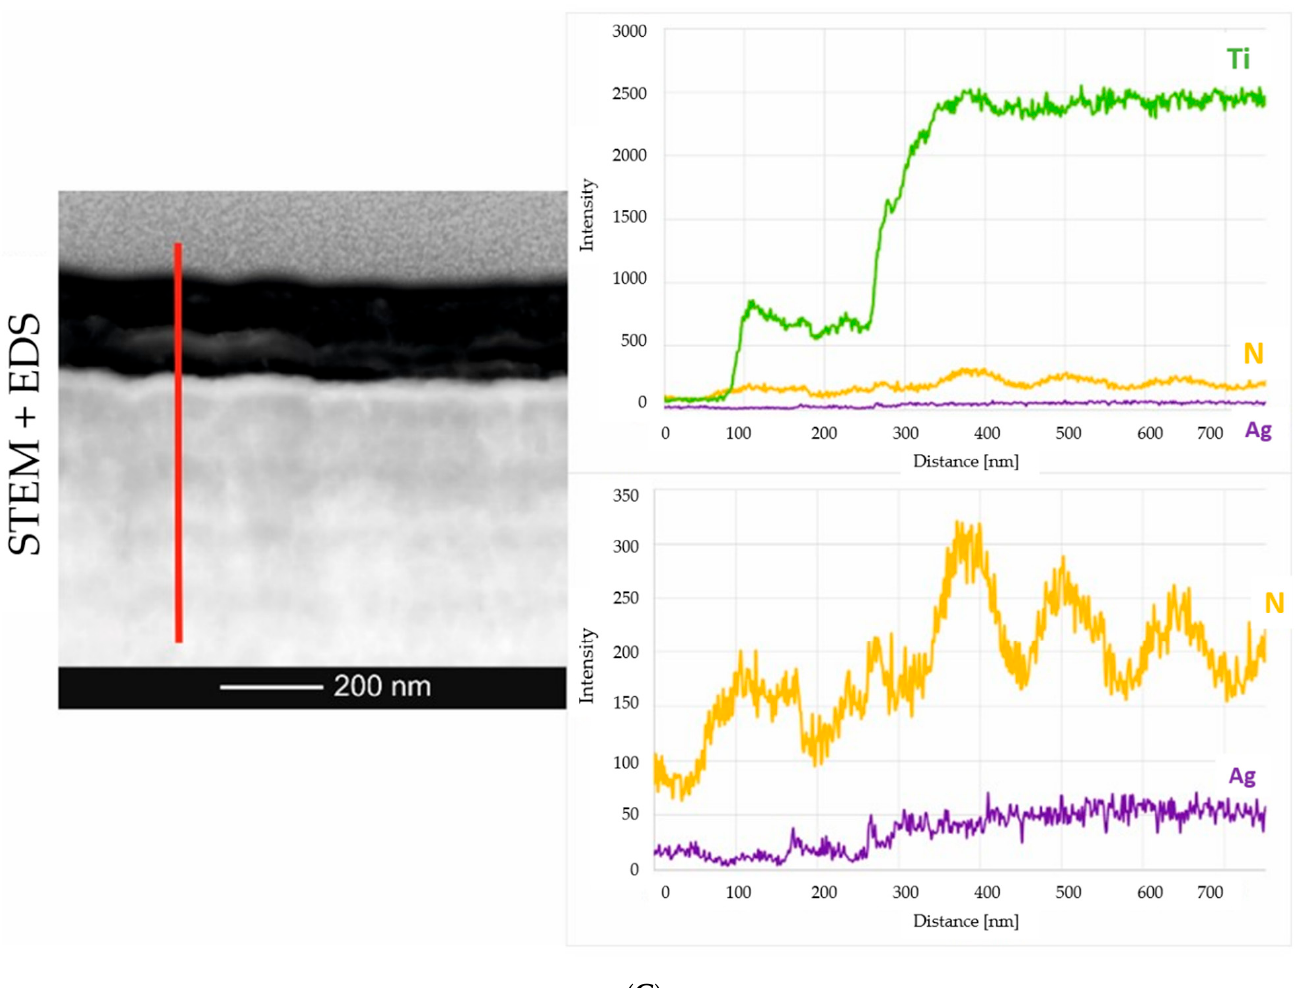
Figure 2. TEM/BF and HREM images of distribution of Ag nanocrystallites in Ti/Ti 2 N multilayer ( A ), STEM image and accompanying maps presenting distribution of Ti, N, Ag, C elements from area marked with square ( B ) and profiles of chemical composition across the multilayer (along the marked line) ( C ).